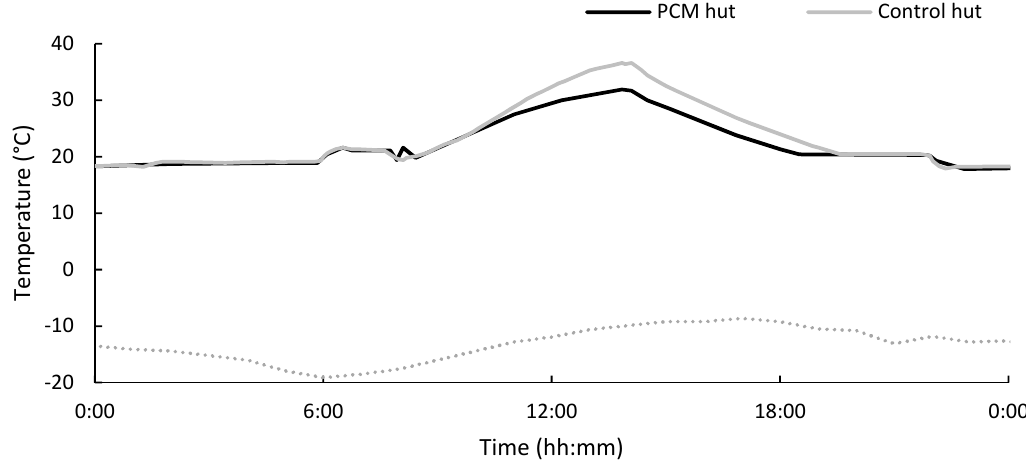
Figure 5. Behaviour of the huts for a sunny winter day (13/02/2018).